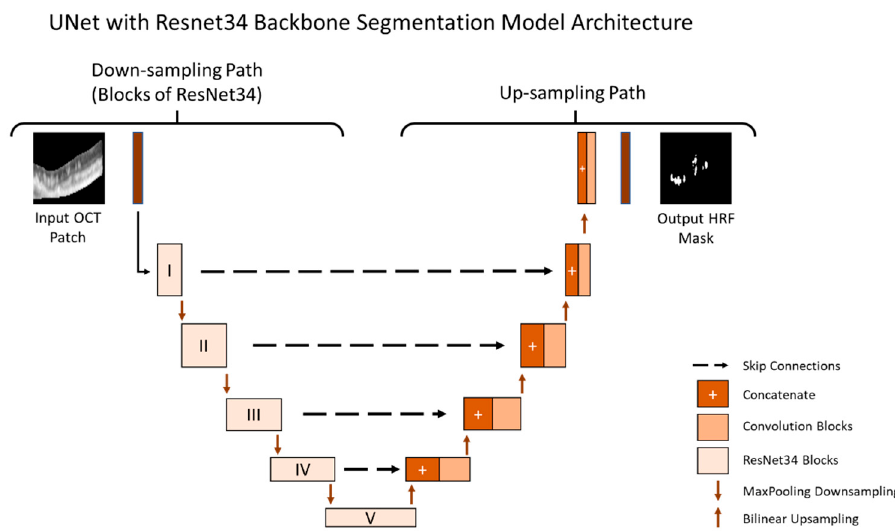
Figure 3. U-Net segmentation model for HRF segmentation.